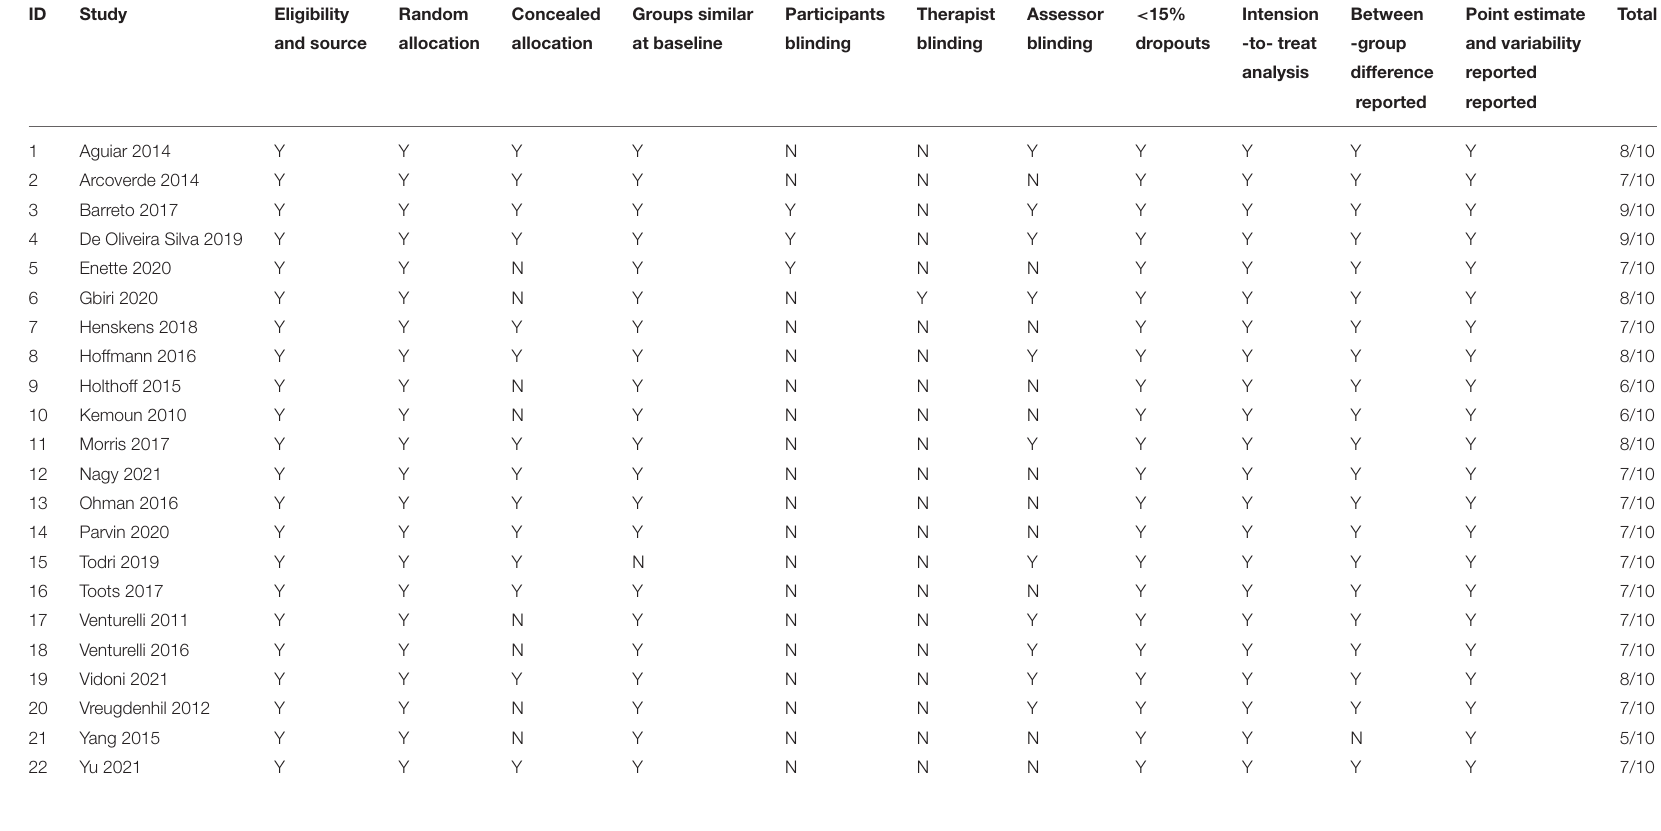
TABLE 2 | Assessment of quality of study design using